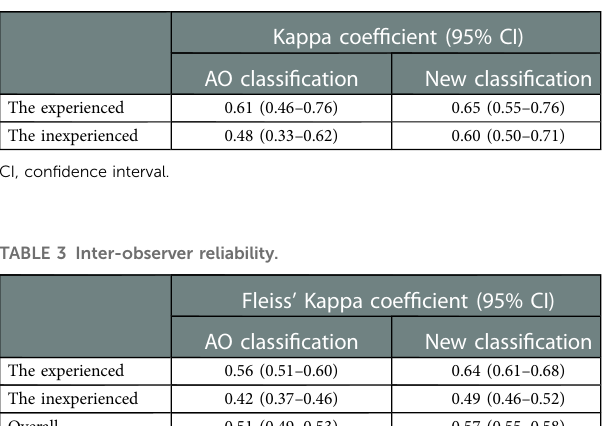
TABLE 2 Intra-observer reliability.